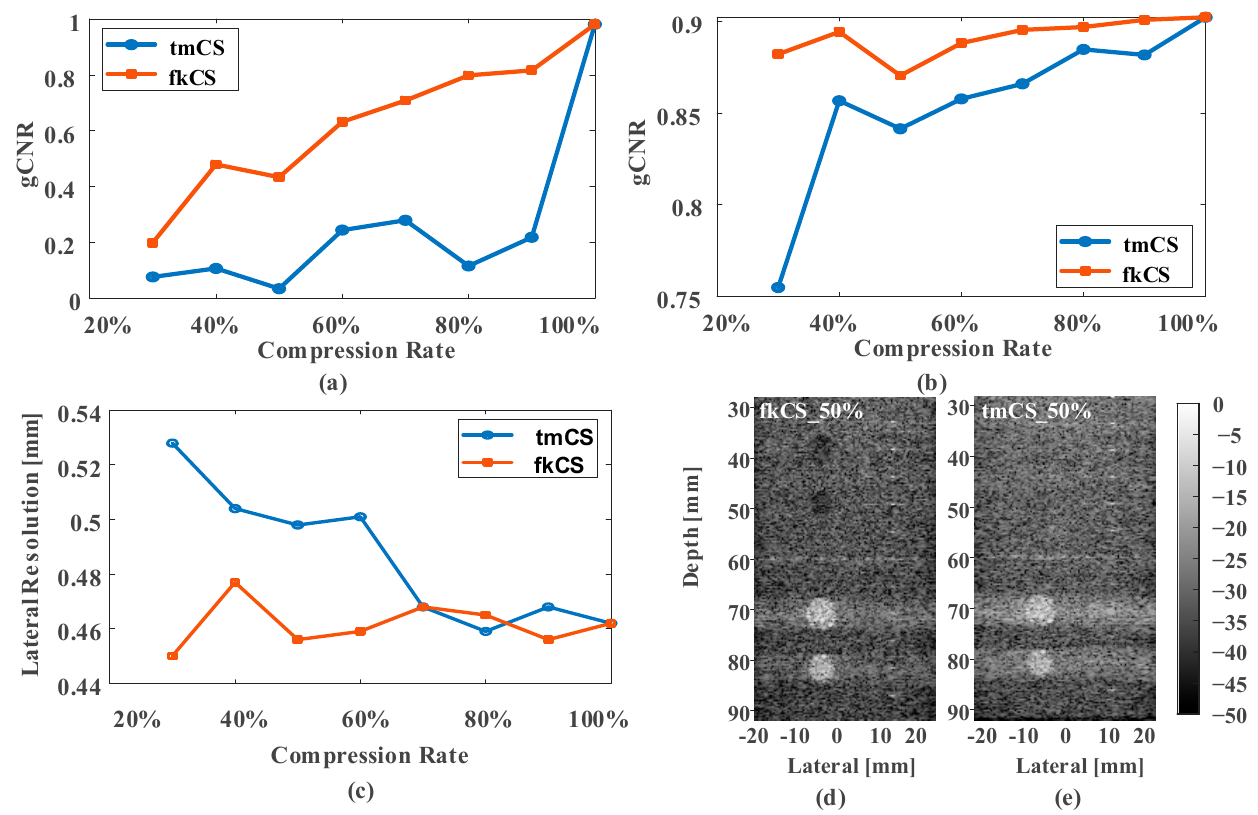
Figure 7. Contrasts and lateral resolutions with different compression rates, as well as B mode images generated by fkCS and tmCS beamforming with hypoechoic, bright region and point scatterers: ( a ) contrast of cyst, ( b ) contrast of strong reflection region, ( c ) lateral resolution, ( d ) B mode image of fkCS with 50% compression rate, ( e ) B mode image of tmCS 50% compression rate. With the decrease in compression rate, the beamformer will take up less memory and less transmission space. However, the information will be lost as well. From B mode